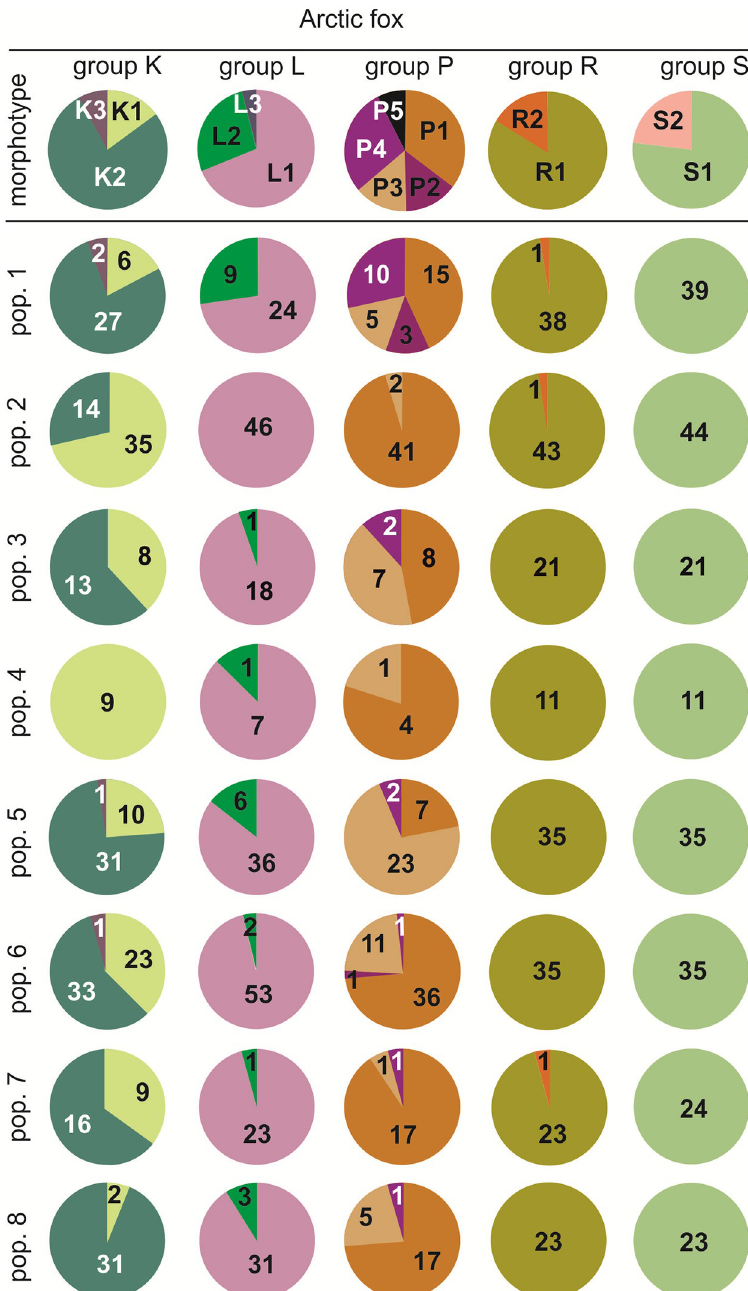
Fig 3. Share of morphotypes in fossil and recent populations of the arctic fox. Numerals in each part of the pie chart are the numbers of specimens with the morphotypes. Illustrations of the tooth variants and morphotypes are shown in Fig 2. Information about the samples can be found in Table